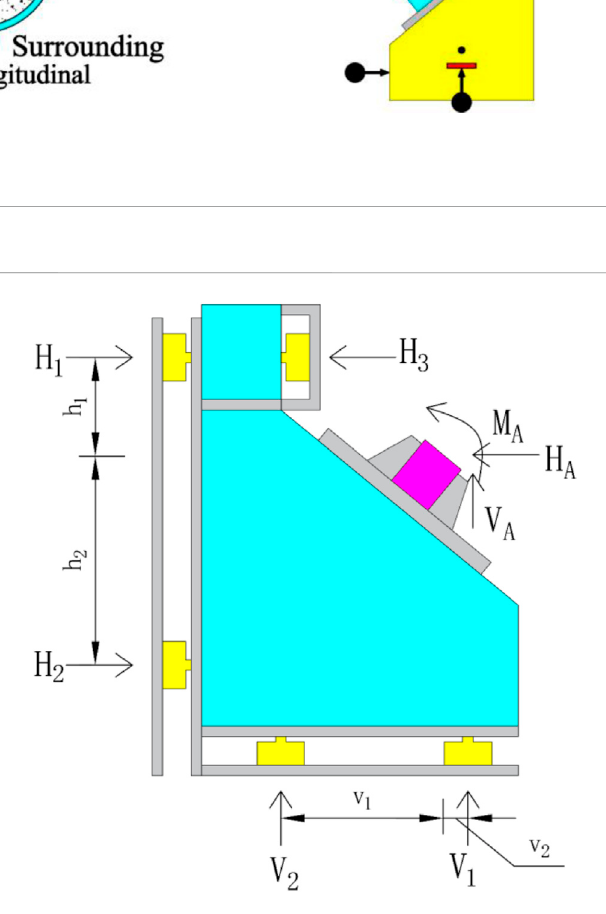
FIGURE 7 Schematic diagram of calculation of the internal force of the arch